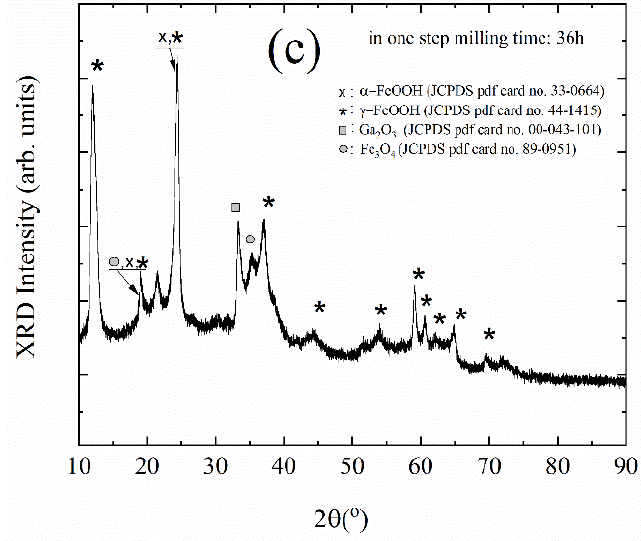
Figure 1. X-ray powder diffraction pattern of prepared samples by ( a ) a rotation speed of 300 rpm with 12 h milling periods, ( b ) a rotation speed of 360 rpm with 12 h milling periods, and ( c ) a rotation speed of 360 rpm without break in the milling. The diffraction patterns were indicated by the Joint Committee on Powder Diffraction Standards (JCPDS) powder diffraction file (pdf) card numbers, such as FeGa 2 O 4 , α —FeOOH, γ —FeOOH, Ga 2 O 3 , and Fe 3 O 4 , which were identified by 01-074-2229, 33-0664, 44-1415, 00-043-101, and 89-0951, respectively).